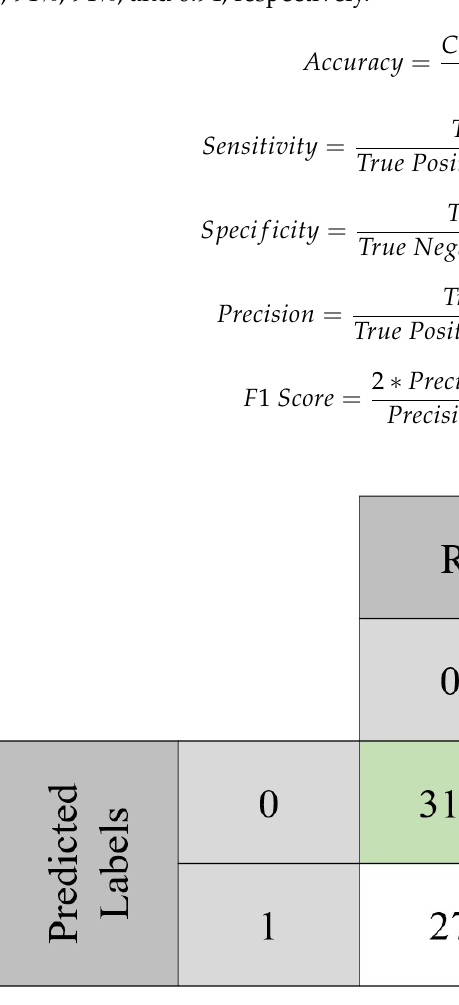
Figure 6. Confusion matrix obtained with the validation set. From the total 693 instances, the model was capable of correctly classify 629 of them. It can also be noted that approximately 92% of the benign lesions were correctly classified, while for the malignant lesions, the same happened for approximately 89% of the